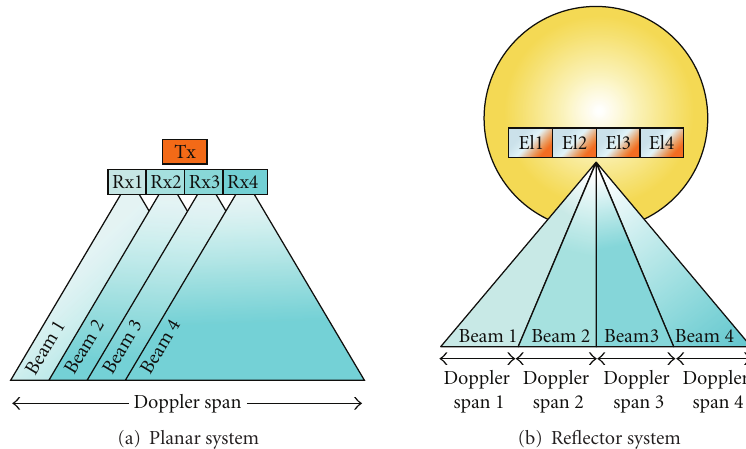
Figure 1: MultiAzimuth channels yield identical wide Doppler span for each channels in case of the planar system (a), and narrow Doppler spans of di ff erent Doppler centroid in the case of the reflector system (b).